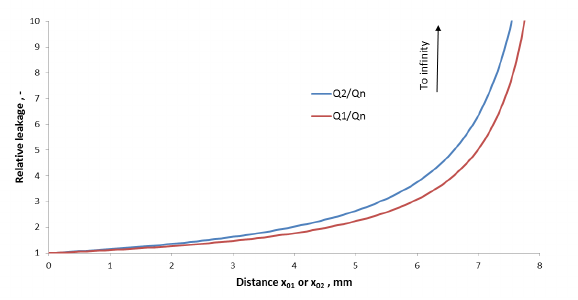
Figure 16: The course of the relative leakage in case 1 and case 2